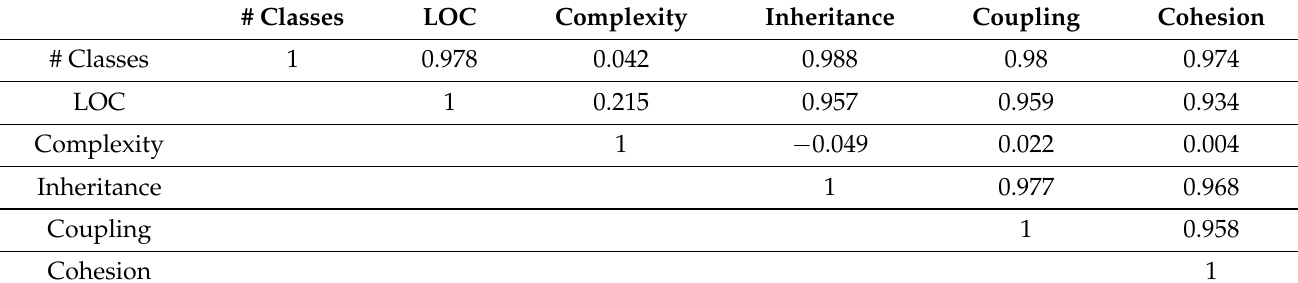
Table 3. The Results of Correlation